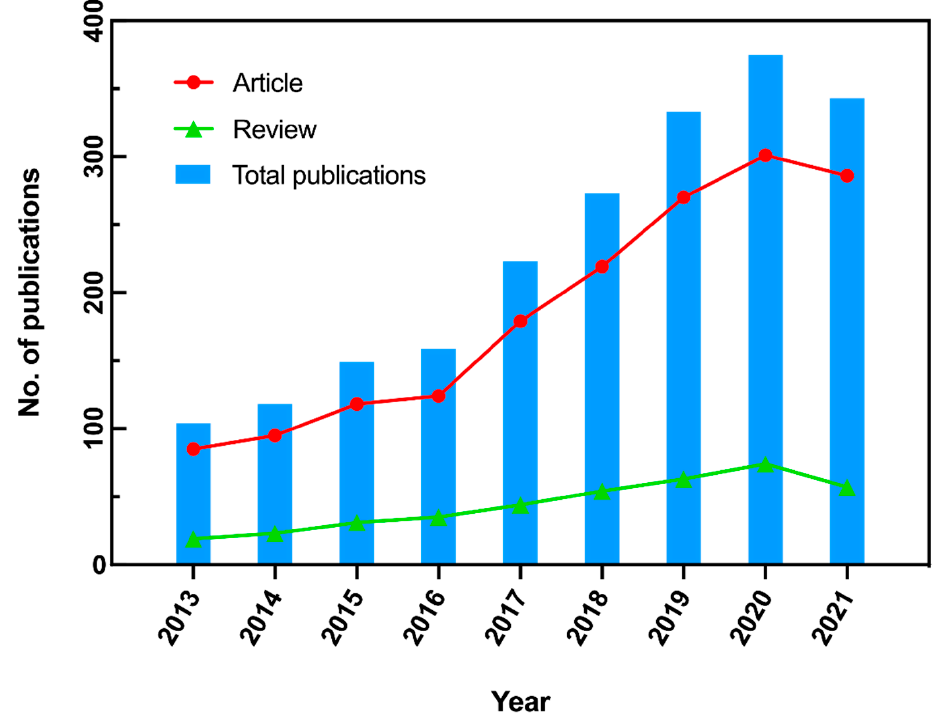
Figure 1. Number of publications on cognitive frailty in the Web of Science Core Collection database from 2013 to 2021. The number of original articles published per year shows a slow growth and then a noticeable rise, while the review exhibits a steady upward